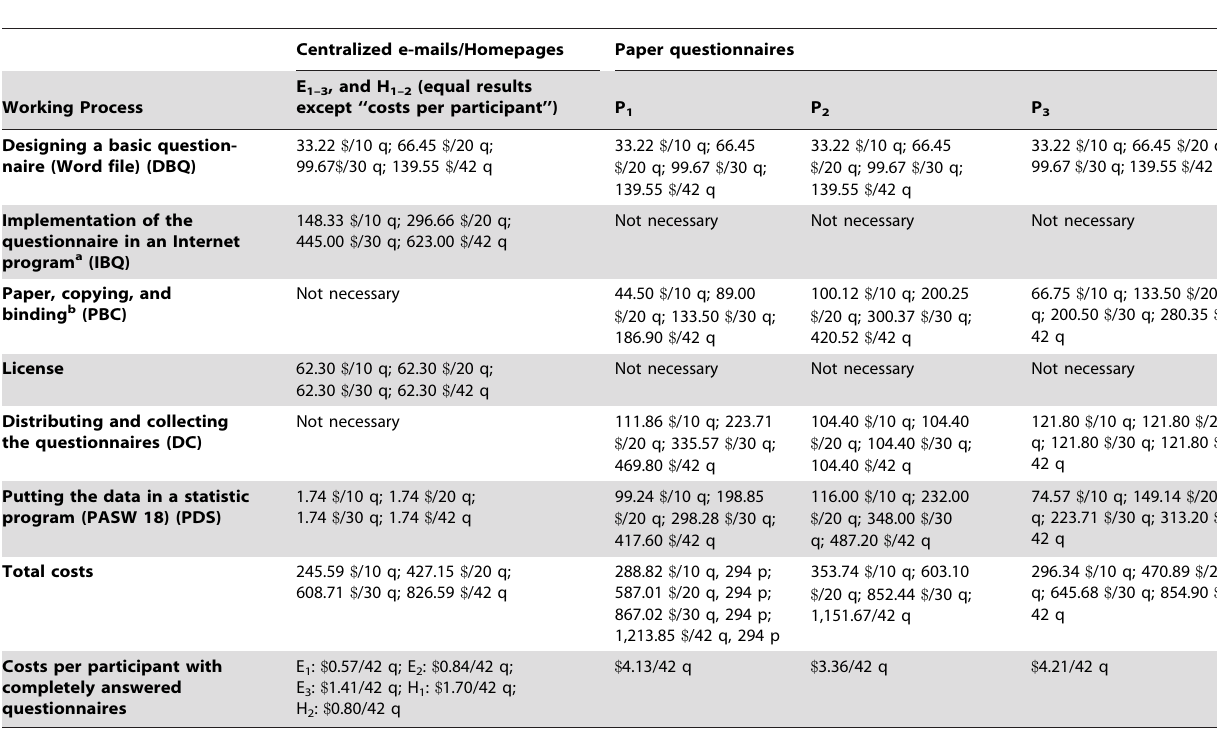
Table 4. Financial costs of our surveys and estimated costs based on a $ 77.8/h, 8 h professional work to establish a